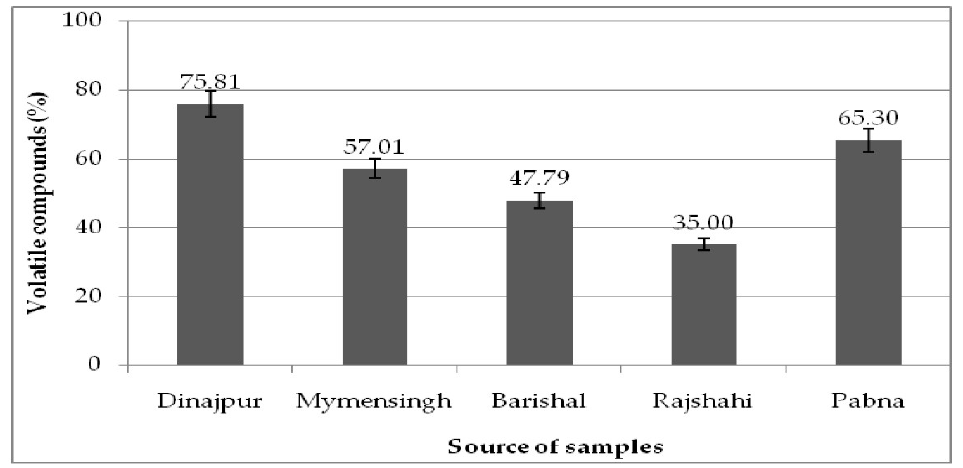
Figure 1. Yield of volatile compounds from hog plum peel samples collected from different districts of Bangladesh.